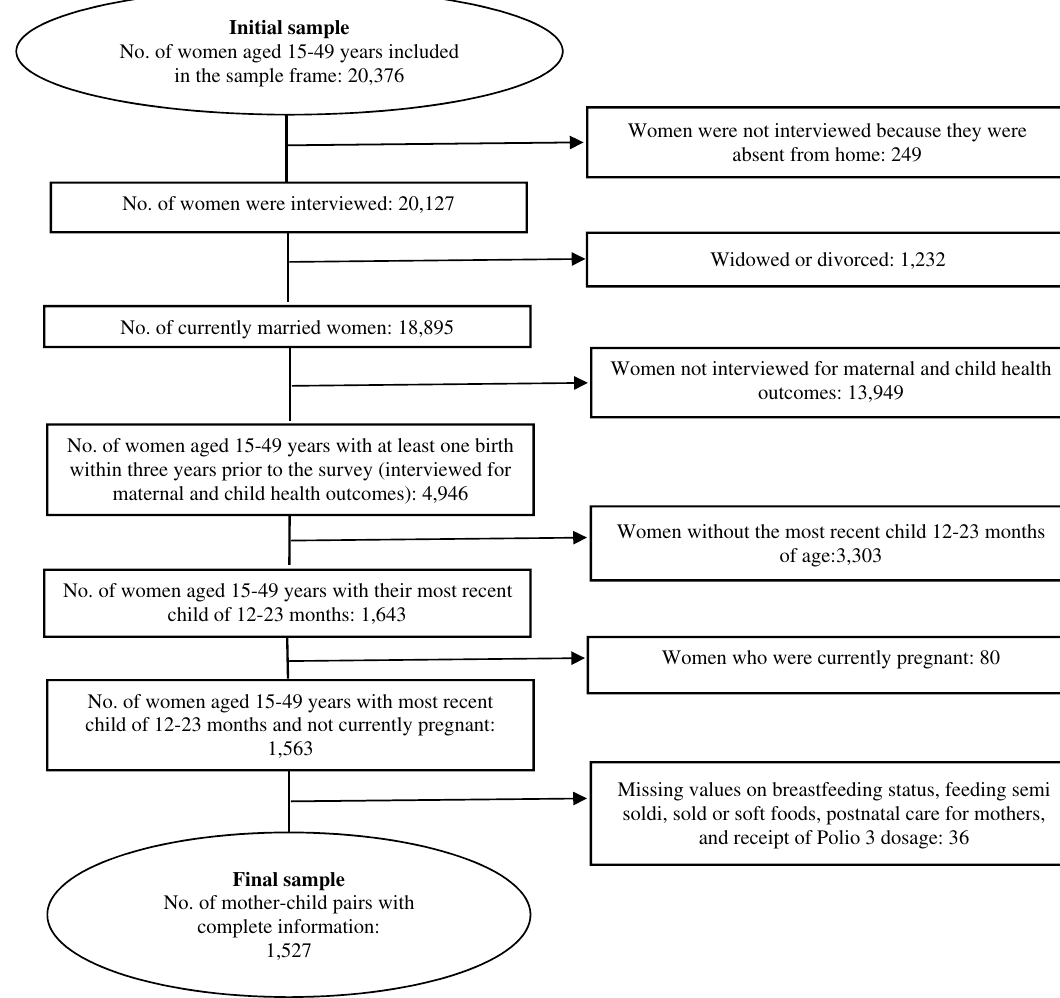
Figure 1. Selection of the sample: Bangladesh Demographic and Health Survey